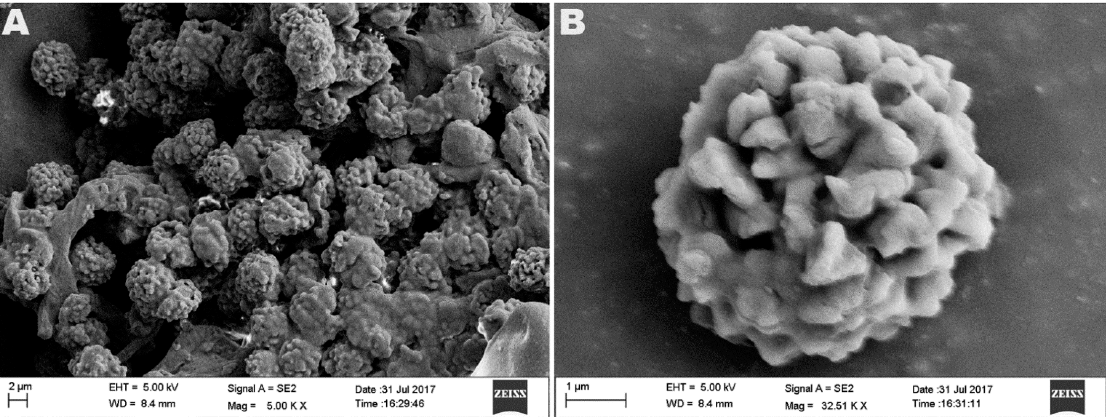
Figure 7. Scanning electron micrographs of U. virens chlamydospores. ( A , B ), Chlamydospores of the fungal pathogen U. virens on the surface of the Dharam rice variety at various magnifications; bar ( A ) = 2 μ m, ( B ) = 1 μ m.